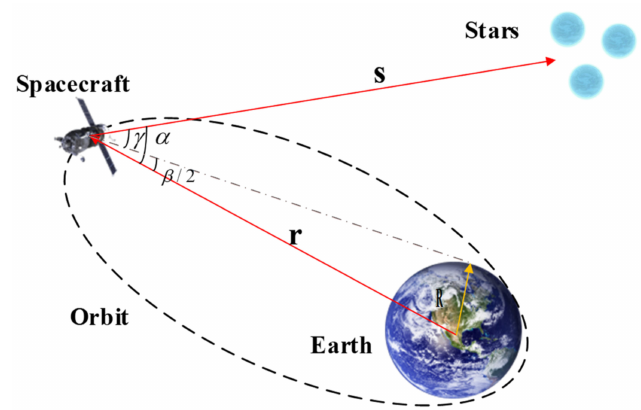
Figure 1. Principle of celestial navigation